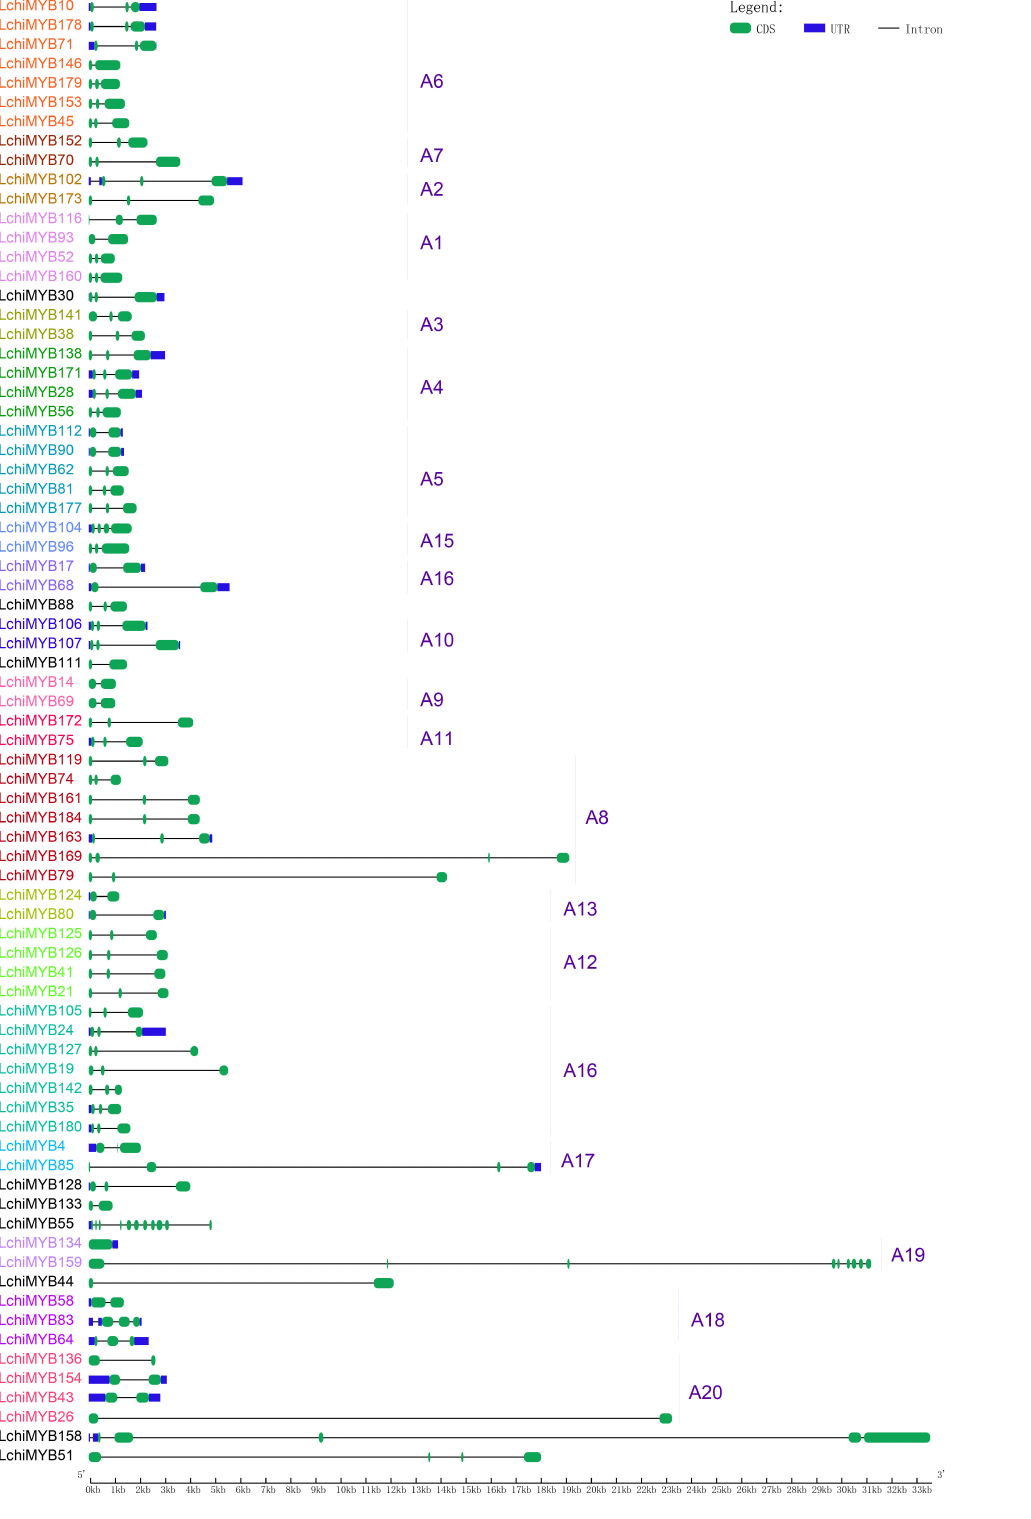
FIGURE 5 | Lchi MYB gene exon-intron structures. Blue rectangles indicate untranslated 5 (cid:48) – and 3 (cid:48) – regions; green rectangles indicate exons; black straight lines represent introns; the tick marks represent the length of the gene. The corresponding groups were labeled (e.g., A1), with different colors on the branches and gene